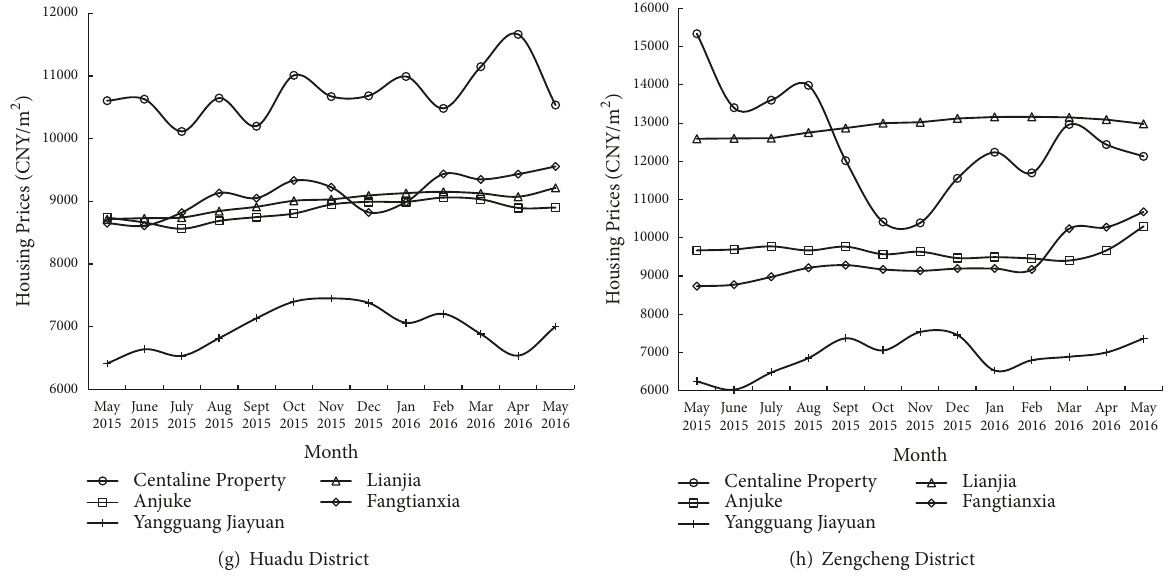
Figure 4: Second-hand residential housing prices of each district (May 2015-May